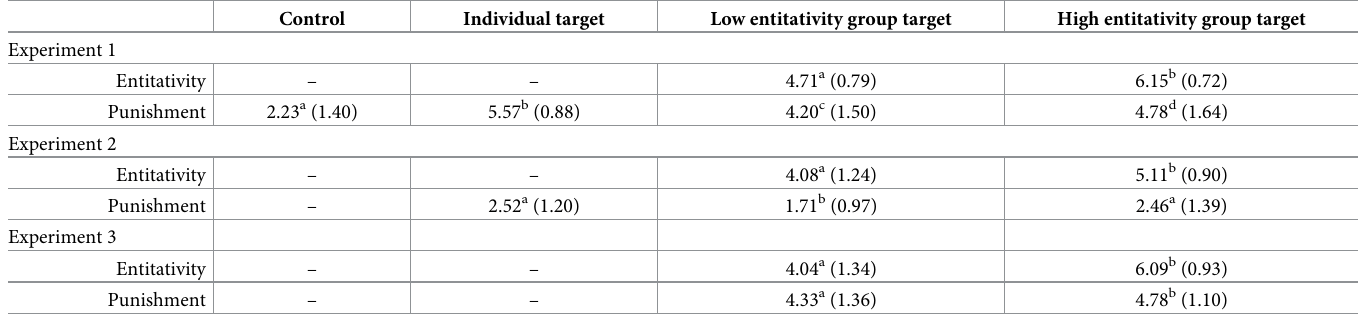
Table 1. Means and Standard Deviations for entitativity perceptions and support for punishment as a function of the experimentl conditions (Experiments 1, 2 &